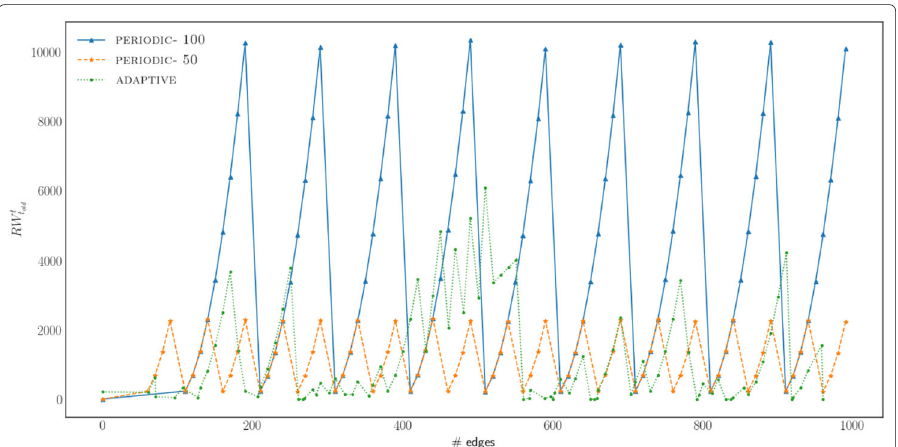
of changes ( cutoff = 4000). As a result, A DAPTIVE is able to perform much better, as depicted by many very low values in the RW t t old